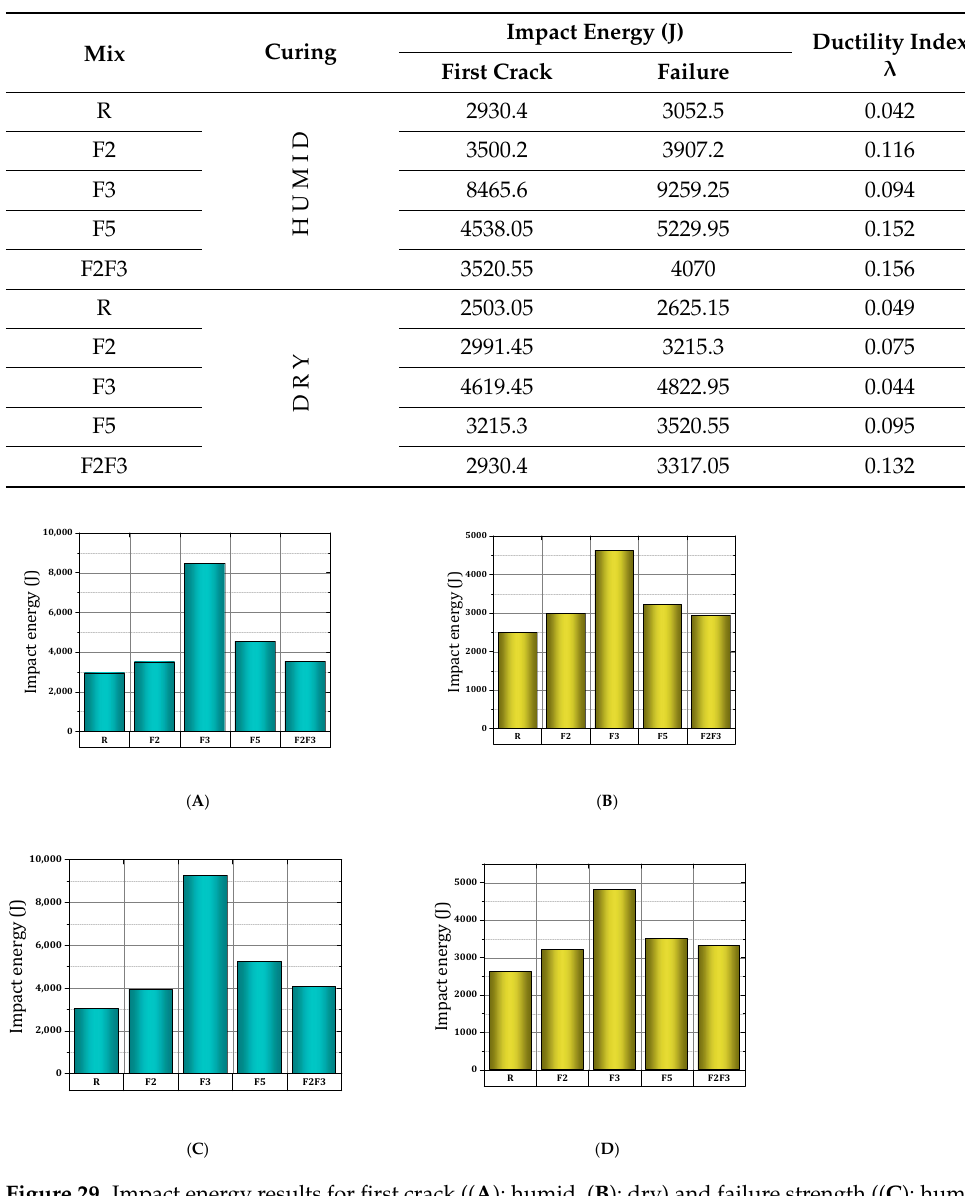
Table 10. The results of impact energy and the ductility index.